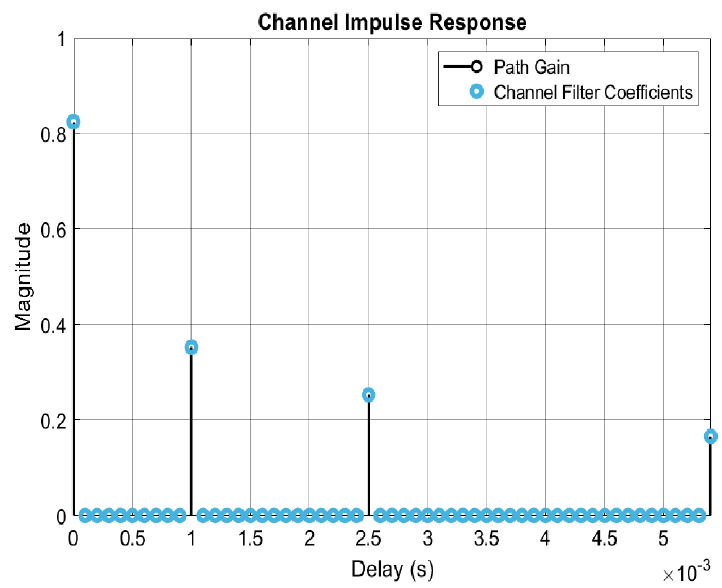
Figure 4. Channel impulse response